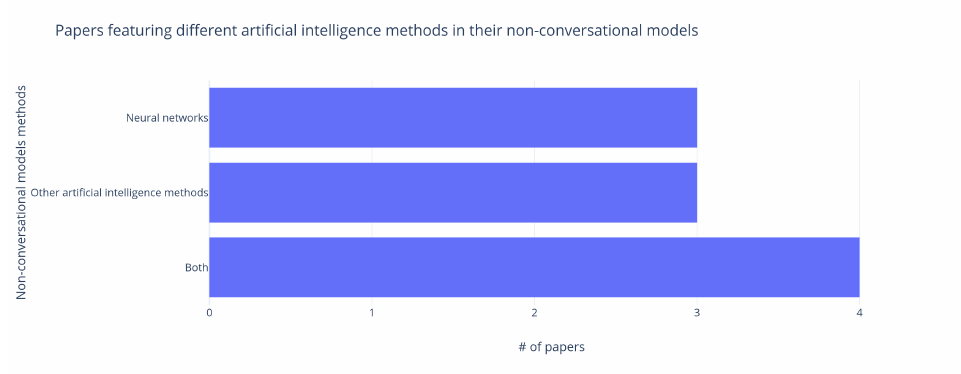
Figure 4. Papers featuring different AI methods in their non-conversational models.